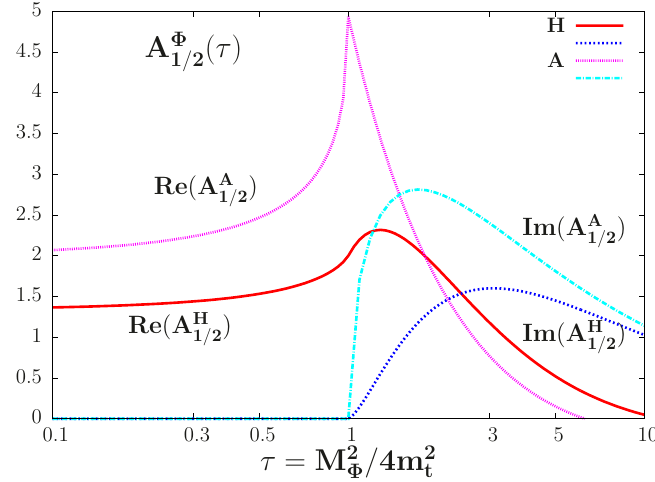
Figure 2 . The real and imaginary parts of the form factors A (cid:8) as functions of the variable (cid:28) (cid:17) M 2